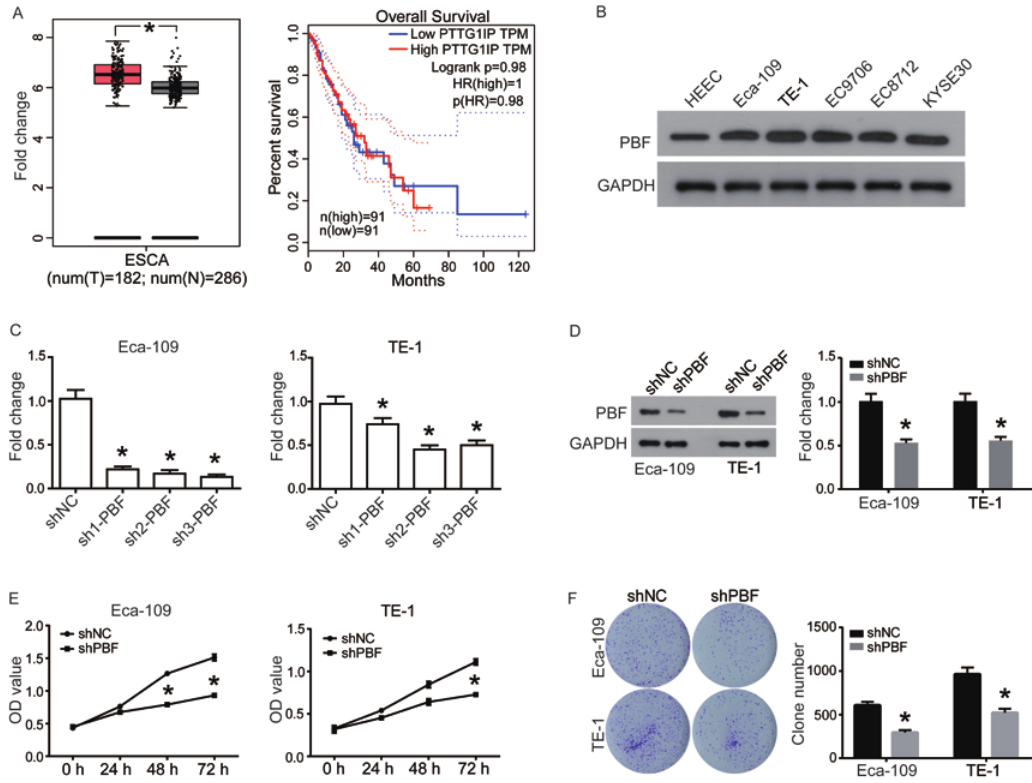
Figure 1: PBF was highly expressed in ESCA and down-regulation of PBF significantly inhibits proliferation of ESCAS cells. (A) Left: The expression of PBF in ESCA tissue (n=182) compared with normal controls (n=286); The red and gray boxes represent ESCA tissue and normal tissues, respectively; Right: The correlation of PBF mRNA expression with the overall survival of patients with ESCA; (B) PBF protein expres- sion was investigated in human normal esophageal epithelial cell line HEEC and ESCA cell lines Eca109, TE-1, EC9706, EC8712 and KYSE30 cells by western blot analysis. (C)RT-qPCR was utilized for detecting mRNA expression of PBF in ESCA cells transfected with shNC or shPBFs for 24 h; (D) Western blot was used to confirm the interference effect of sh2-PBF on PBF protein level. (E) CCK8 assay was utilized for analy- zing cell proliferation of Eca-109 and TE-1 cells, which were pre-transfected with shNC or sh2-PBF for 24 h; (F) Clone formation of the Eca-109 and TE-1 cells after transient transfection with shNC or sh2-PBF for 24 h. All experiments were repeated 3 times. * P represented significant